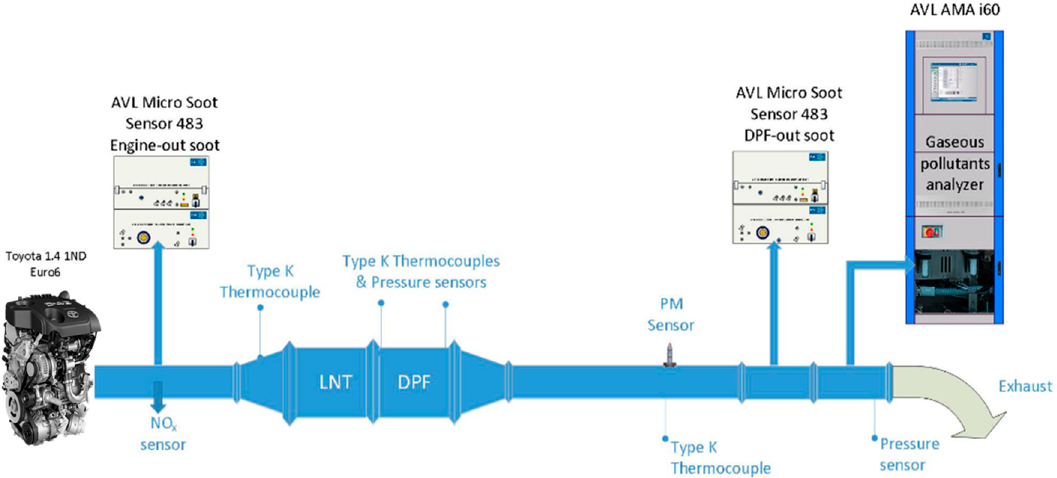
Figure 2. Test engine set-up with exhaust gas analyzers and sensors.